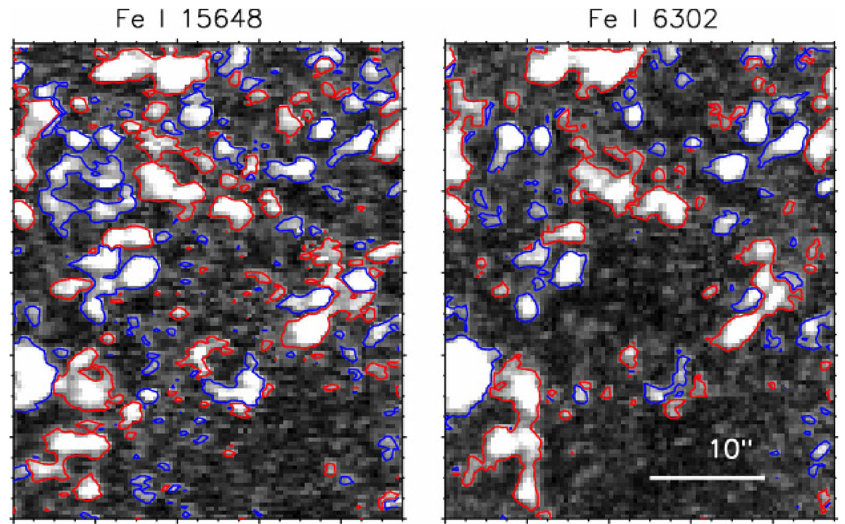
Fig.29 Circular polarization maps of a quiet Sun area taken simultaneously in the Fe i 1564.8 nm line (left panel, TIP) and in the Fe i 630.25 nm line (right panel, POLIS). The red and blue contours outline positive and negative polarities, respectively. The scale is the same in both maps. Image reproduced with permission from Khomenko et al. (2005a), copyright by